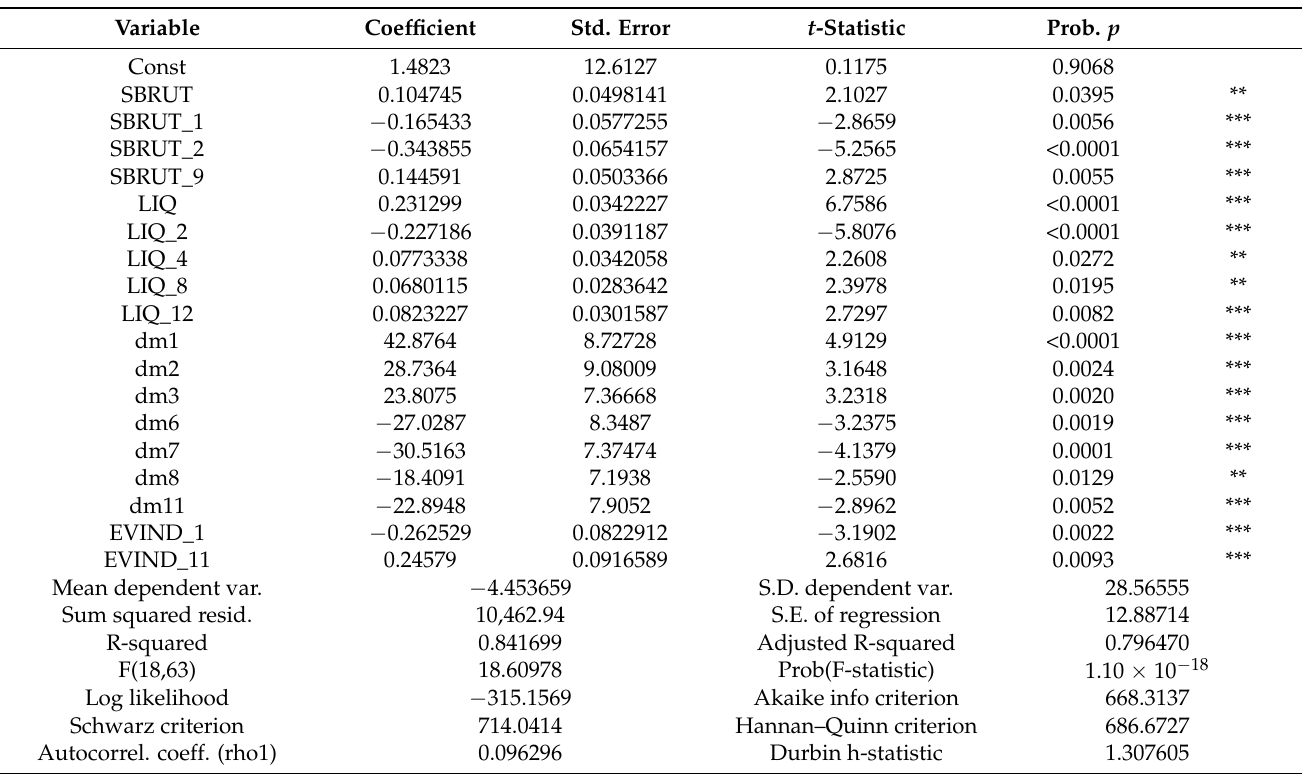
Table 2. Dependent variable: EVIND t ; observations used 1997:03–2003:12 (N = 82).